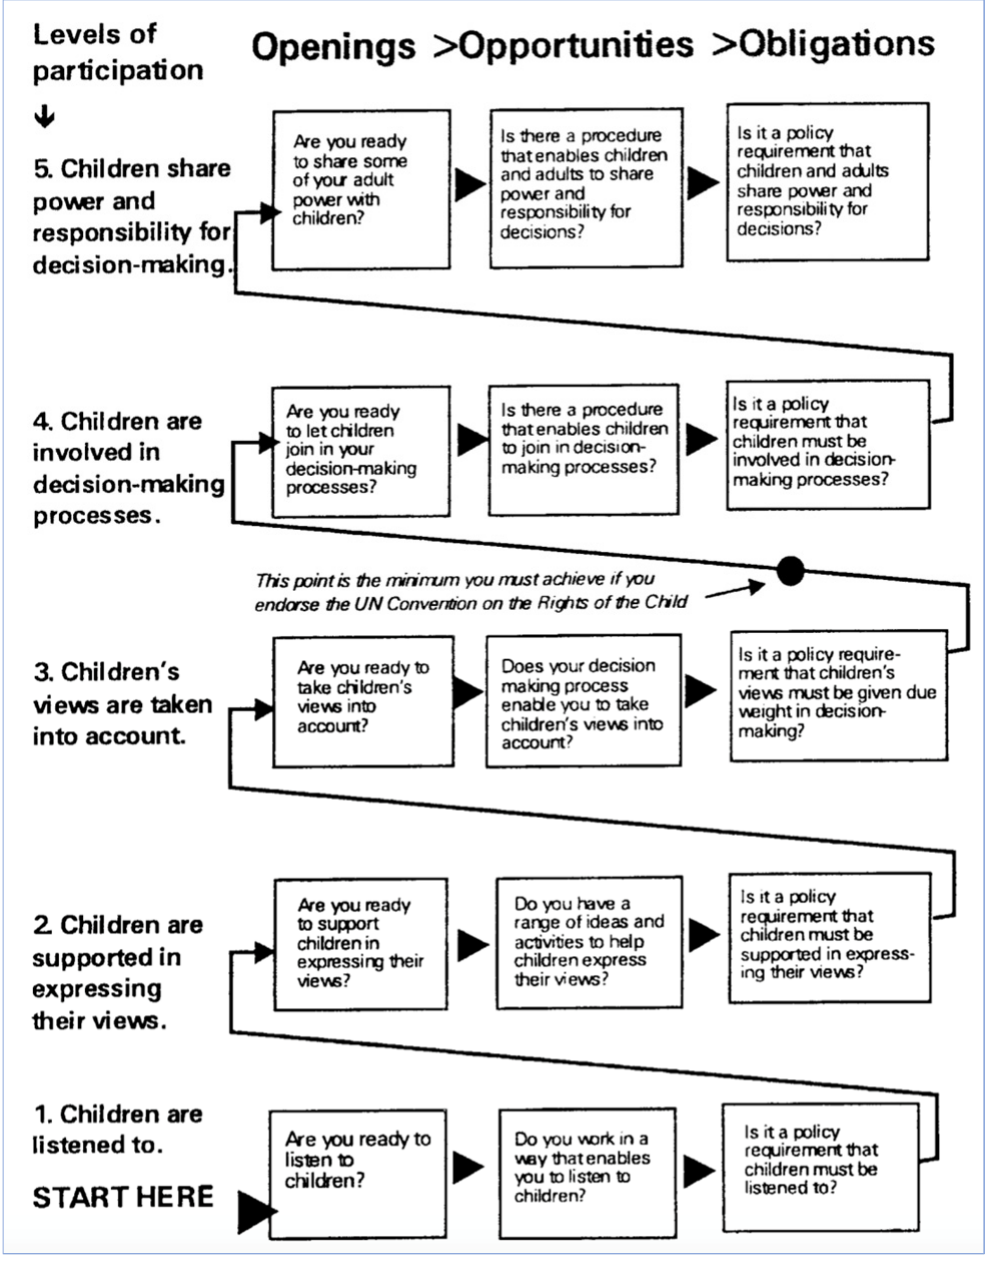
Figure 3. Shier’s (2001) Pathways to